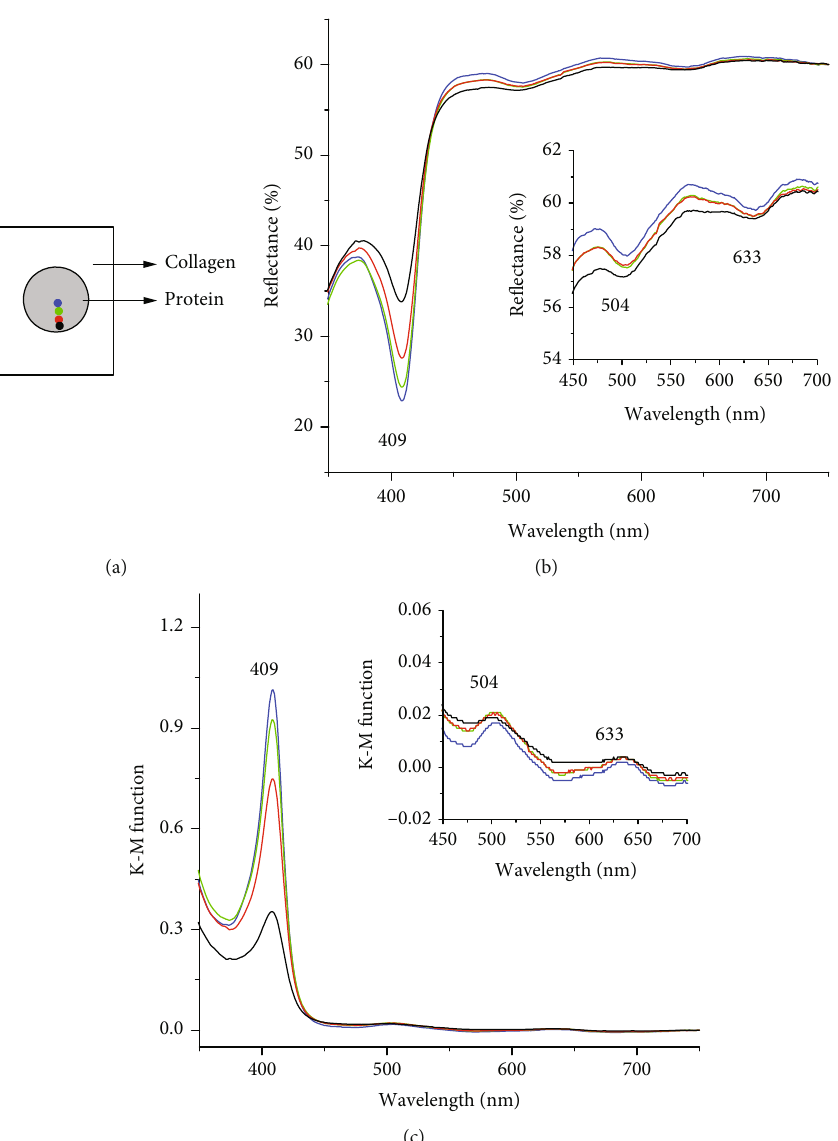
Figure 4: (a) Scheme of the 12 μ M met-aquo Mb added to collagen. Colored circles represent the monitored positions. (b) UV-Vis di ff use re fl ectance measures and (c) the Kubelka-Munk function obtained from measured di ff use re fl ectance for their respective colored spots. The insets show an expanded view of the 450-700 nm